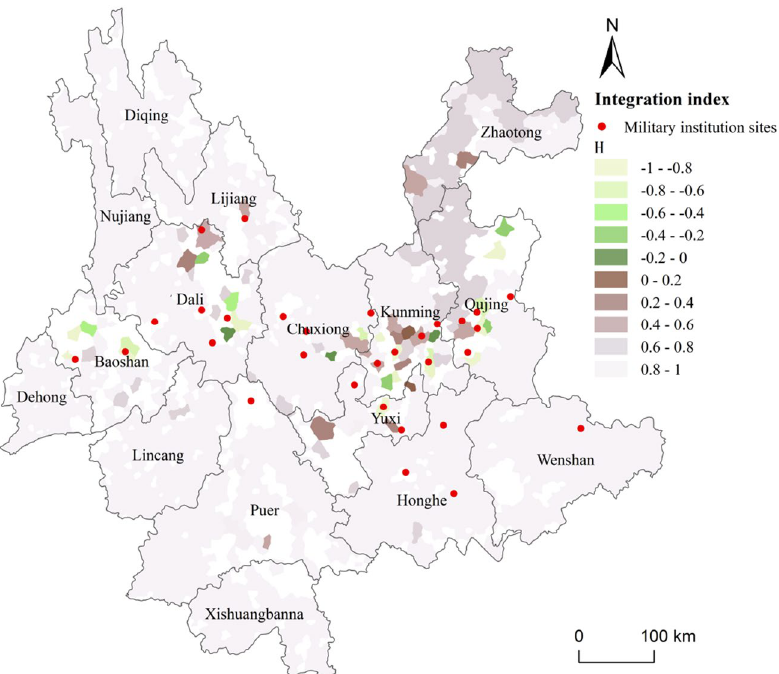
Figure 7. Spatialization results of integration index(Hi), blank areas are areas where toponyms are distributed discretely. The map was created in ArcGIS Pro v.2.7: https:// www. esri. com (Esri, California, USA). The final layout was created in ArcGIS Pro v.2.7: https:// www. esri. com (Esri, California,